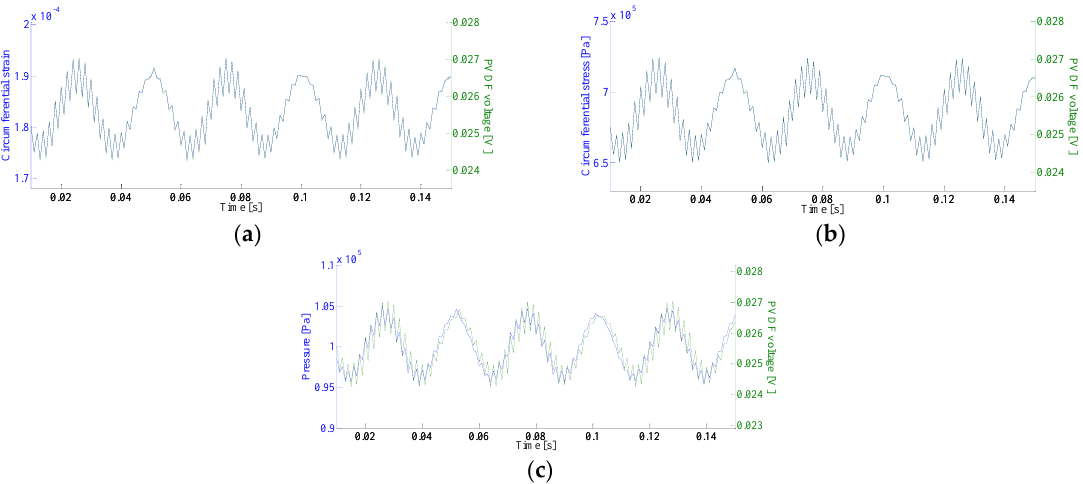
Figure 9. Comparison curves of ( a ) circumferential strain at Point2 and PVDF2 voltage; ( b ) circumferential stress at Point2 and PVDF2 voltage; ( c ) fluid pressure and PVDF2 voltage.